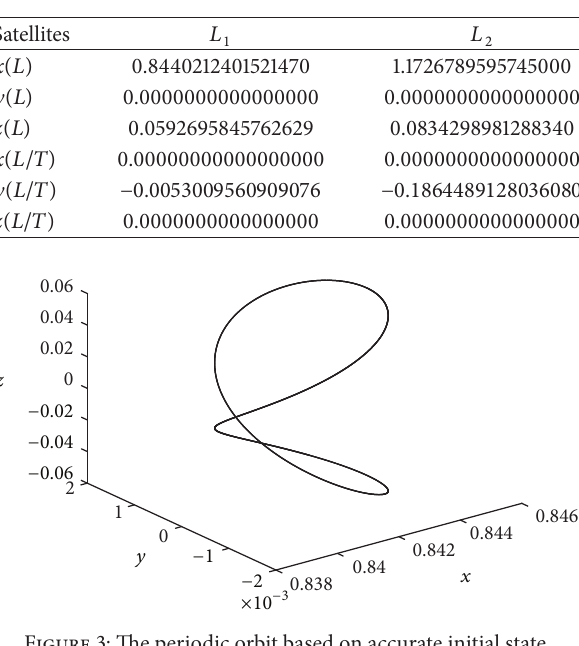
Table 1: Initial states of the periodic orbits around Lagrange points 𝐿